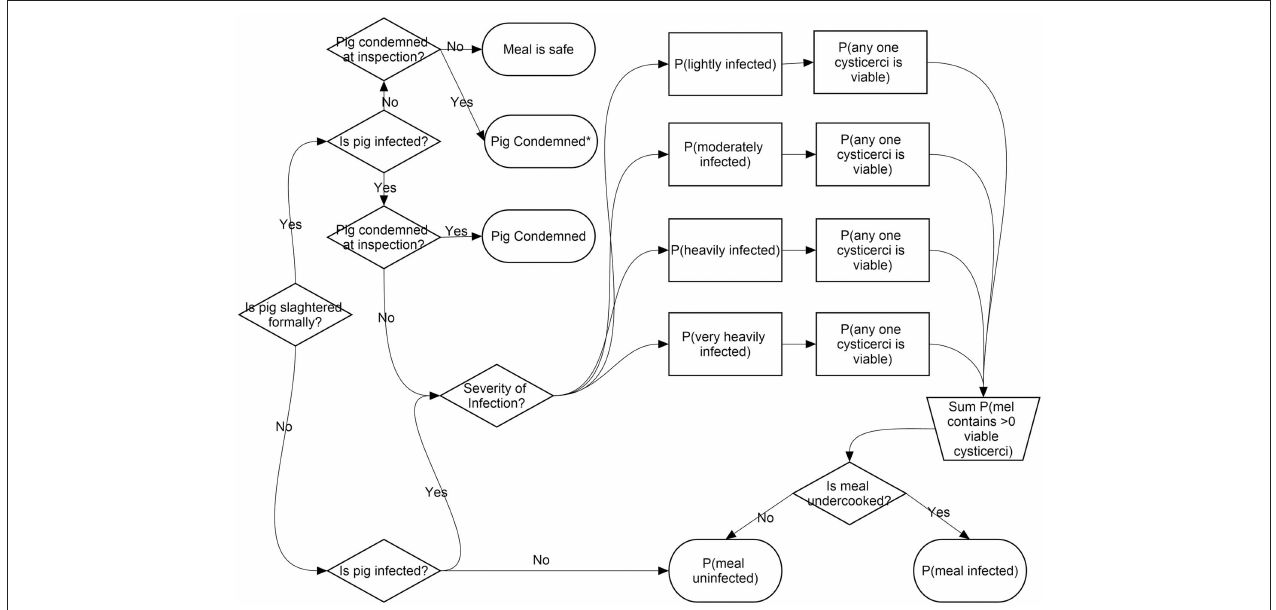
FIGURE 1 | Food chain risk model structure © 2017 Thomas et al. Reproduced from Thomas et al.